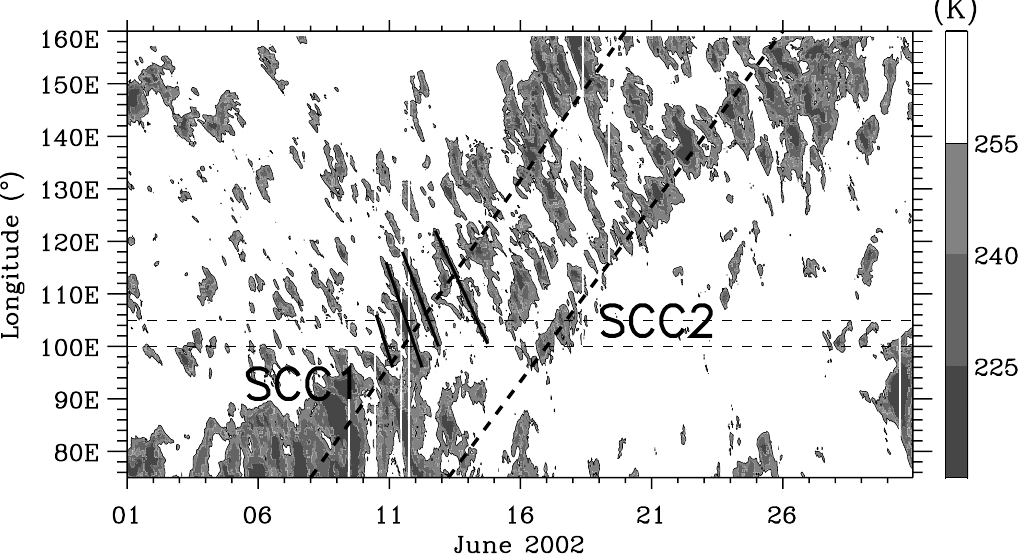
Fig. 3. Time-longitude plot of T BB averaged over 1 ◦ S–1 ◦ N in June 2002. Longitudinal resolution is 0 . 2 ◦ . Thin horizontal broken lines indicate the longitude of 100 ◦ E and 105 ◦ E. Thick broken lines show the propagation of SCC1 and SCC2, while thick solid lines show the propagation of